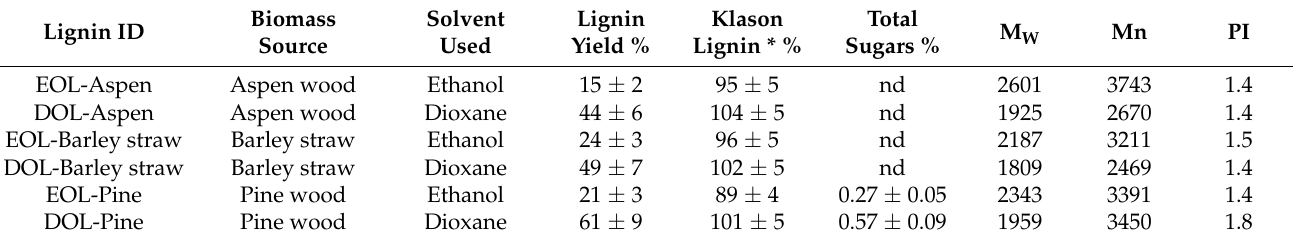
Table 1. Physicochemical characterization of organosolv lignin that was extracted from different sources of biomass with two different solvents (ethanol organosolv lignin- EOL and dioxane organo- solv